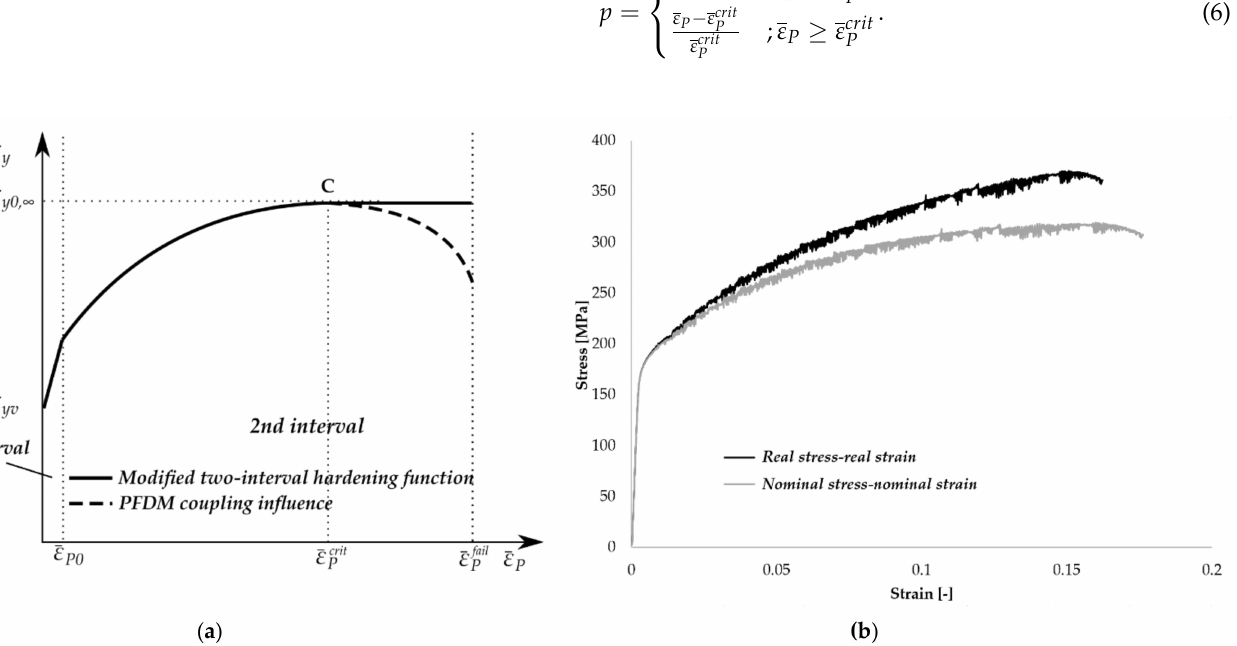
Figure 4. The modified two-interval hardening function for the simulation of AA5083; ( a ) simplified stress-strain theoretical response and ( b ) real and nominal stress-strain response of the AA5083 specimen’s experimental testing ( σ y —yield stress of current yield surface, σ y 0, ∞ —saturation hardening stress, σ yv —initial yield stress, ε P 0 —maximal equivalent plastic strain for linear hardening plasticity interval, ε crit —critical equivalent plastic strain, ε fail —failure equivalent plastic strain, P P ε P —equivalent plastic strain, C—critical